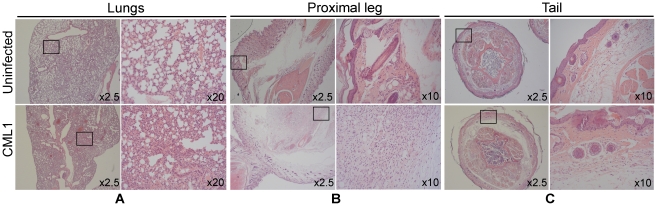
Histological examinations of lungs (A), proximal leg (B) and tail (C) of nu/nu mice infected i.n. with CML1.Hematoxylin and eosin-stained tissues are shown at day 45 post-infection for uninfected nu/nu mice (upper panels) and animals infected with CML1 by i.n. instillation (lower panels). (A) In CML1 infected animals, in comparison with uninfected animals, the lung tissue is characterized by open alveolar spaces, bronchioli without changes, and some dilated vessels in the interalveolar septa. (B) The disease induced in CML1 infected animals is also characterized by a massive edema of the muscular compartment of the proximal leg. (C) Histopathological changes in the tail upon infection are indentified by a diffuse infiltrate of neutrophils that extends from the deep dermis up to the underlying bone. Magnifications are indicated on each panel, and the 10× or 20× images represent the boxed region of the corresponding 2.5× image.